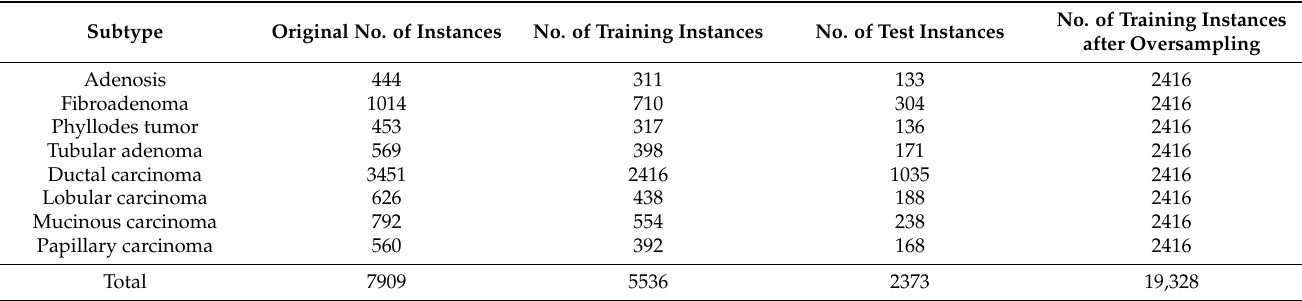
Table 4. The distribution of benign and malignant images over various subtypes after applying augmentation